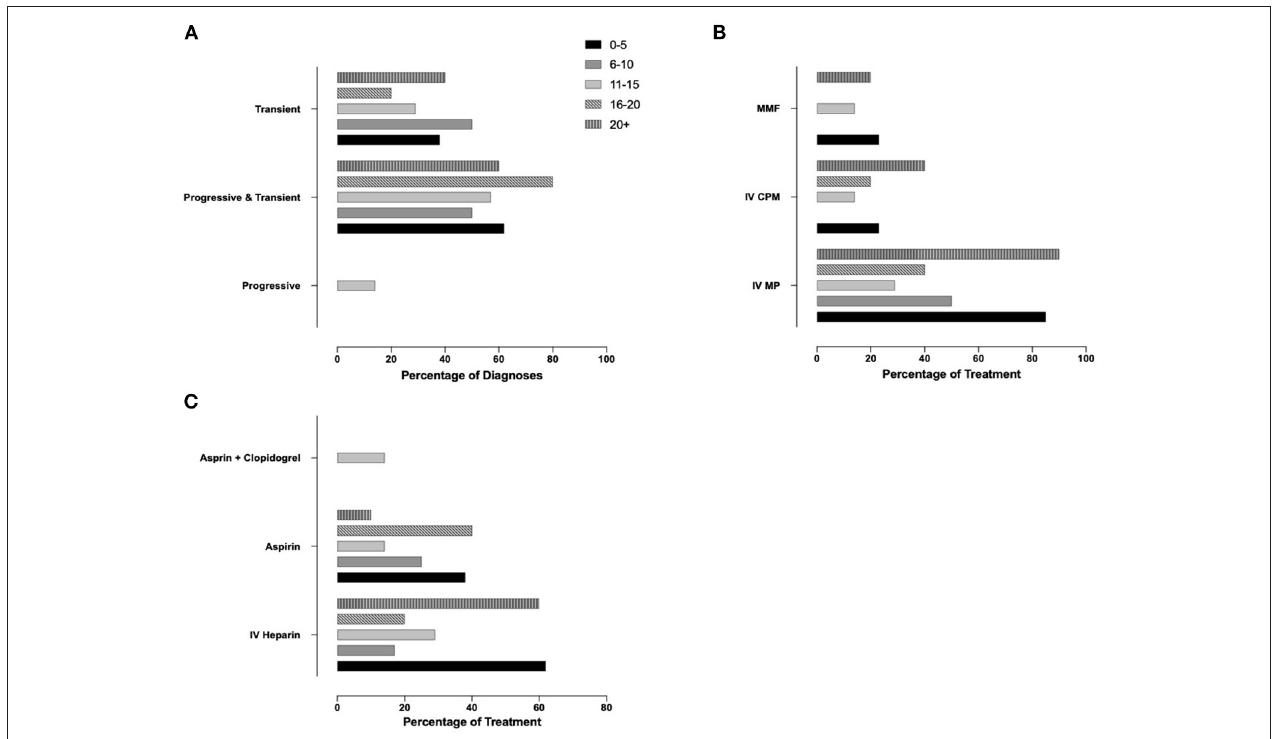
FIGURE 6 | Influence of Experience in Approach to Diagnosis and Treatment in case 2. (A) Correlation between number of years of experience clinicians had and their diagnosis of the patient in case 2. (B) Years of experiences vs. Induction treatment. (C) Years of experience vs. Acute anticoagulation treatment.